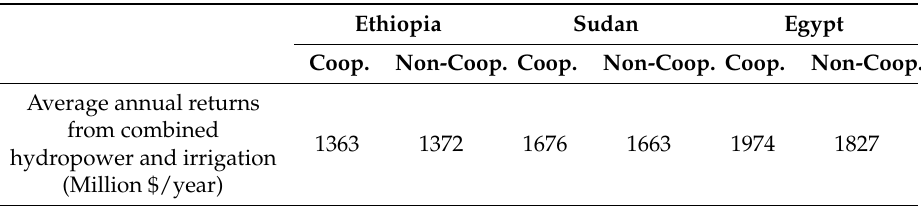
Table 3. Summary of key performance criteria comparing the status quo (without the GERD) with the cooperative and non-cooperative management scenarios. Coop.